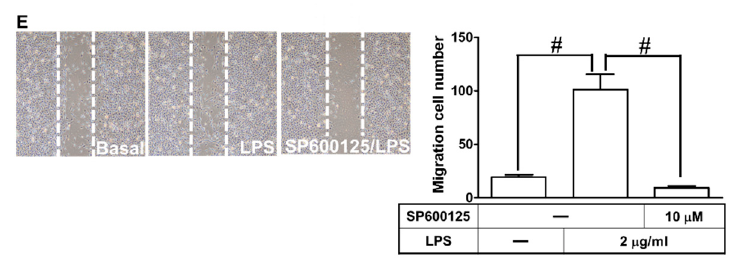
Figure 8. Jun amino-terminal kinase (JNK)1 / 2 were involved in LPS-induced MMP-9 expression and cell migration. ( A ) RBA-1 cells were pretreated with SP600125 (1, 3, and 10 µ M) for 1 h, and then incubated with LPS (2 µ g / mL) for 24 h. The levels of MMP-9 were determined by gelatin zymography. The GAPDH level of cell lysates was assayed by western blot. ( B ) Cells were pretreated with SP600125 (10 µ M) for 1 h, and then incubated with LPS (2 µ g / mL) for 4 h for mRNA expression or 6 h for promoter activity. The mRNA expression and promoter activity of MMP-9 were determined by real-time PCR and promoter assay, respectively. ( C ) Cells were transfected with scrambled (Scrb) or JNK1 siRNA, and then incubated with LPS (2 µ g / mL) for 24 h. The medium and cell lysates were collected to respectively determine the levels of MMP-9 by gelatin zymography, and the levels of GAPDH and JNK1 by western blotting. ( D ) Cells were pretreated with or without SP600125 (10 µ M), c-Src inhibitor II (3 µ M), AG1296 (10 µ M), PF431396 (10 µ M), Akt inhibitor VIII (3 µ M), or LY294002 (10 µ M) for 1 h, or separately transfected with TLR4 siRNA, and then challenged with LPS (2 µ g / mL) for the indicated time intervals (0, 10, 30, and 45 min). The phosphorylation of JNK1 / 2 was determined by western blotting. ( E ) RBA-1 cells were pretreated with SP600125 (3 µ M) for 1 h, and then incubated with LPS (2 µ g / mL) for 48 h. The number of cell migrations was determined (magnification = 40 × ). Data are expressed as mean ± SEM of three independent experiments. # p < 0.01 as compared with the cells exposed to vehicle or LPS, as indicated.